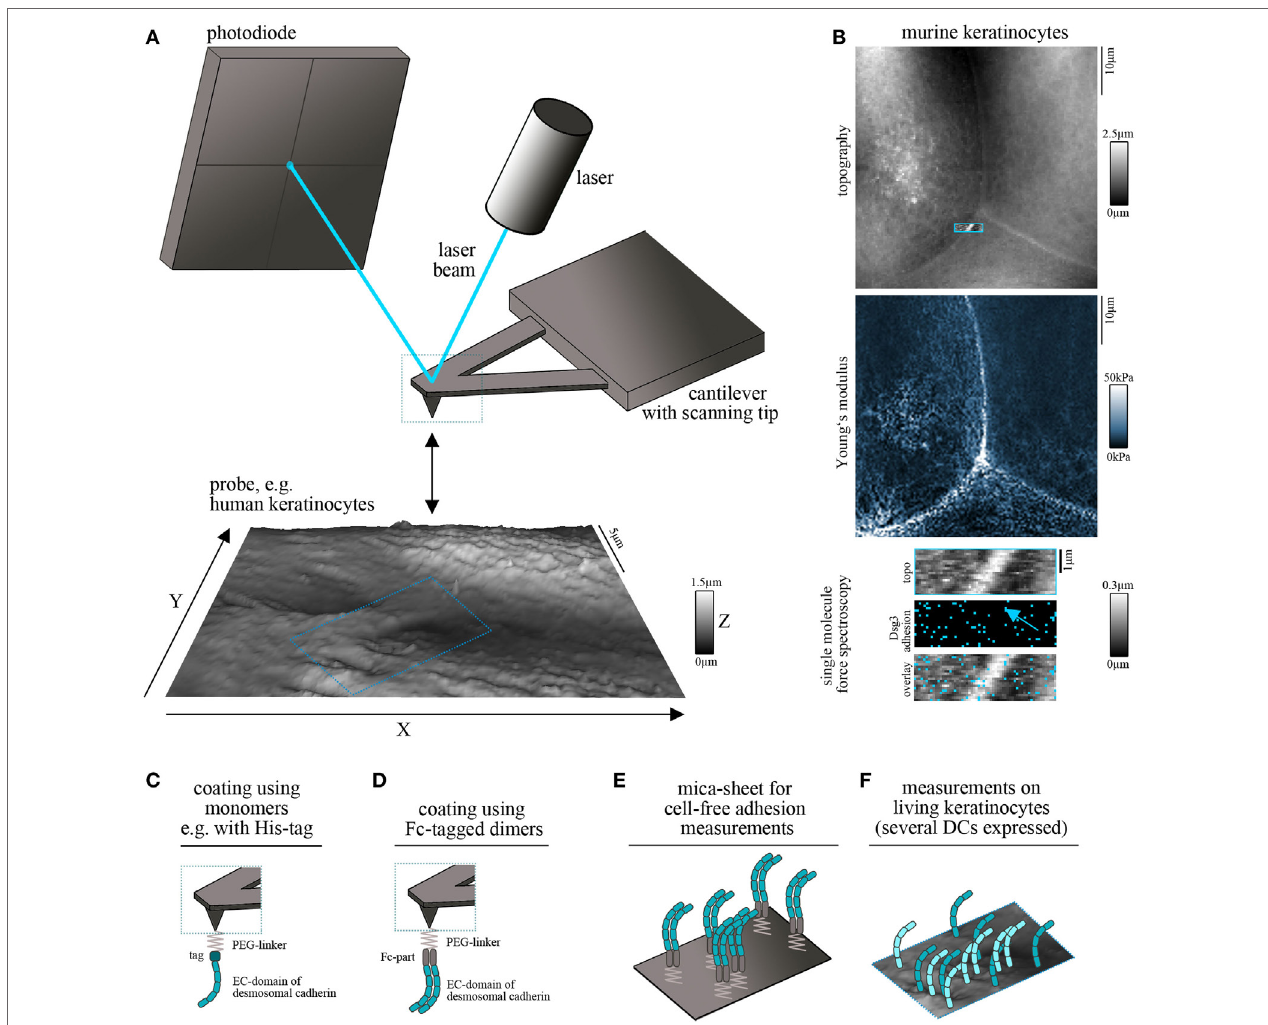
FiGURe 1 | Atomic force microscopy (AFM) setup for cadherin binding studies. (A) Schematic of an AFM setup. A flexible cantilever equipped with a sharp tip is repetitively lowered to and retracted from the surface of the probe. Deflection of the cantilever while contacting the surface is detected by a laser pointed on the cantilever and provides information about surface topography and mechanical properties. (B) Example for simultaneous measurement of topography (with elevated cell borders and filamental structures on the cell surface), elasticity (Young’s modulus) and Dsg3 adhesion map (with each blue pixel represents on Dsg3-dependent binding event, arrow points on the cell border) on living murine keratinocytes. (C,D) To study single-molecule interaction tips can be functionalized with recombinant adhesion molecules using PEG-linkers. For desmosomal cadherins coating was conducted using full-length extracellular domains as either monomers (C) or Fc-tagged dimers (D) . (e) Probe setup for cell-free measurements on mica sheets coated with Fc-tagged dimers of desmosomal cadherin extracellular domains. (F) Probe setup for measurements on living keratinocytes. Cells express several desmosomal cadherin isoforms on their cell